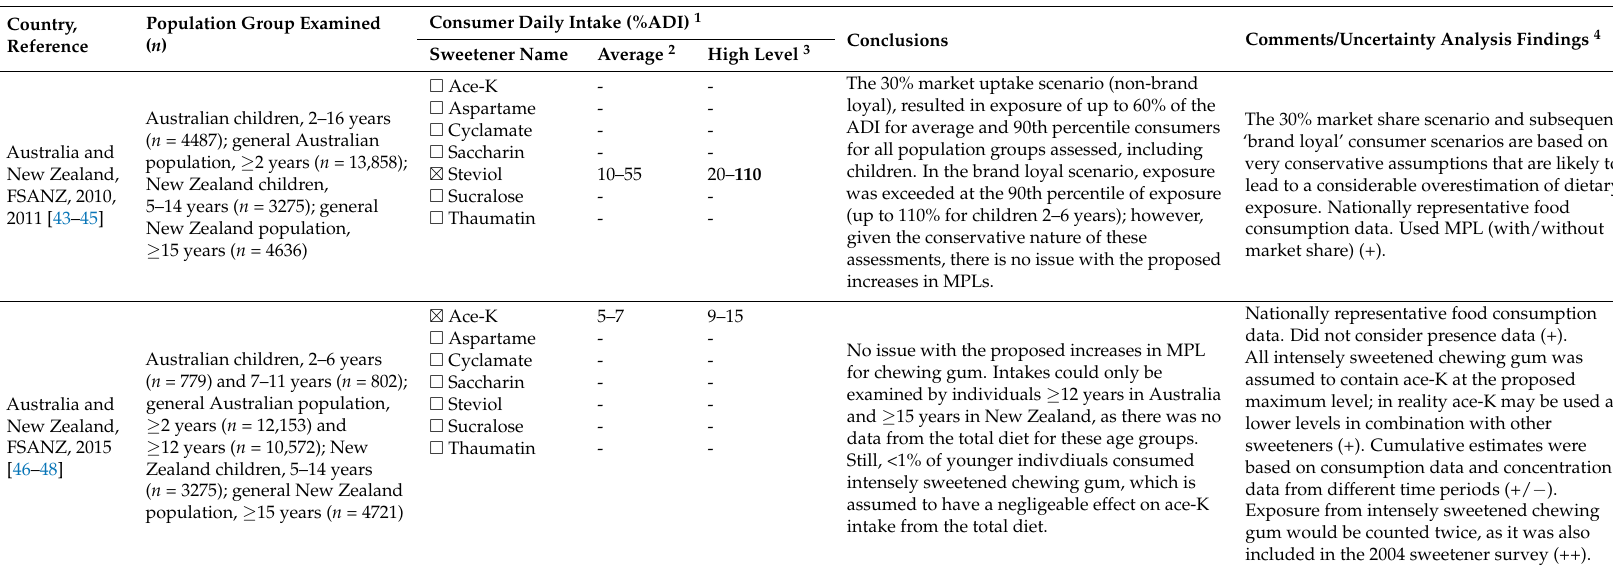
Table 2. Estimated Daily Intakes of Low-/No-Calorie Sweeteners in Australia/New